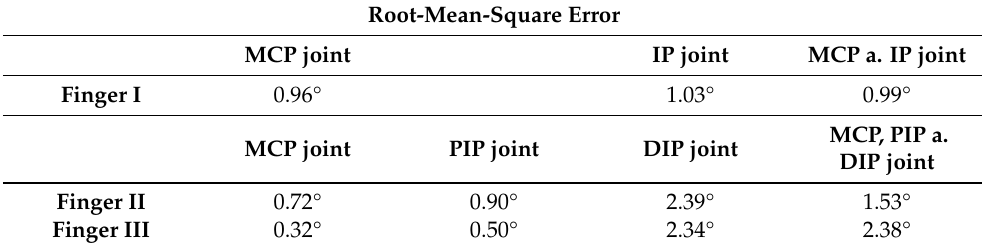
Table 2. Root-mean-square error of all measurements for finger I (thumb) to finger III (middle finger). Joints: Carpometacarpal (CMC), Distal Interphalangeal (DIP), Interphalangeal (IP), Metacarpophalangeal (MCP), Proximal Interphalangeal (PIP).